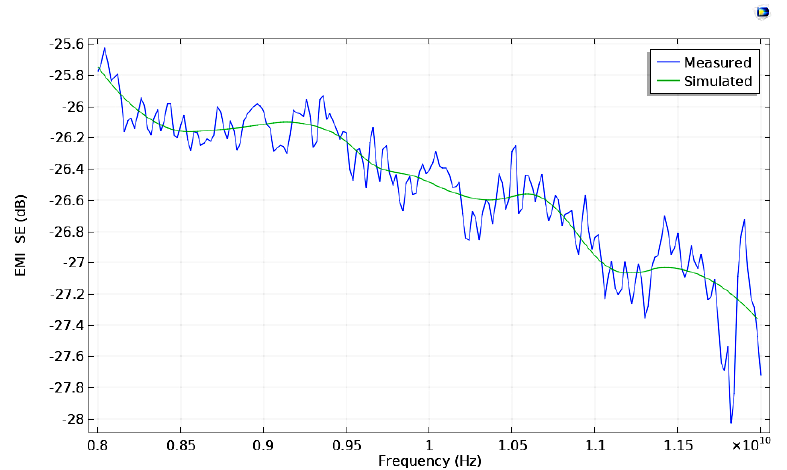
Figure 11. Shielding Effectiveness comparison between measured and simulated